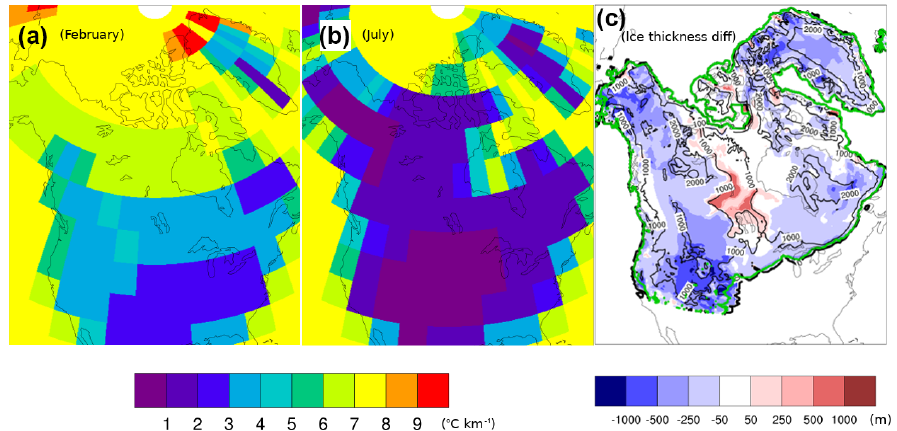
Figure 3. Vertical temperature lapse rate calculated by the coupler at PD over NA in (a) February and (b) July. (c) Shows the ice thickness difference between dynamic and constant 6.5Kkm − 1 lapse rate (control) runs after running for 2kyr, starting from the same 110ka con- figuration. Black contours show the ice thickness in the control run. Thick black and green contours show the ice margin in the control and dynamic lapse rate run, respectively.